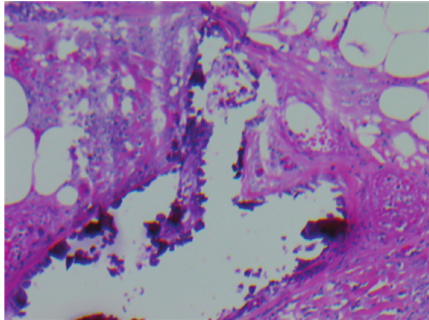
Figure 1: Histology of skin biopsy of patient 4 showing calcific arteriolopathy typical of calciphylaxis. Haematoxylin and eosin stain, magnification 200x.